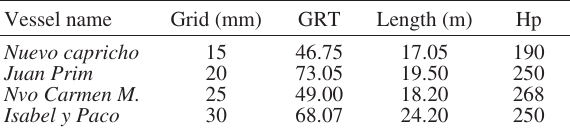
Table 1. – Mean characteristics of the vessels used in this study. Vessel name